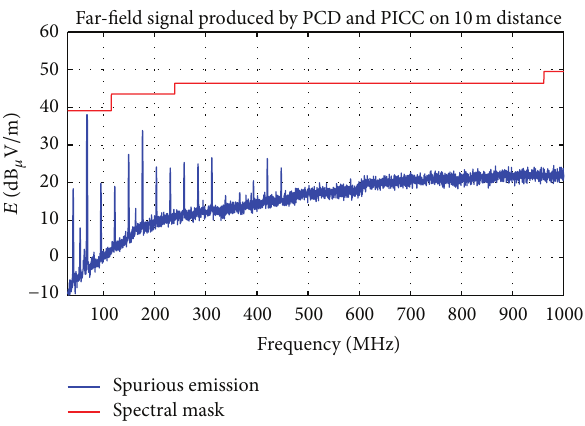
Figure 12: Emission measurement in GTEM cell (PCD and